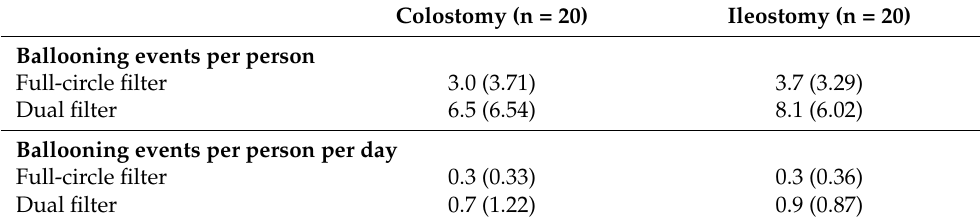
Table 2. Number of ballooning events per person with the full-circle filter versus the dual